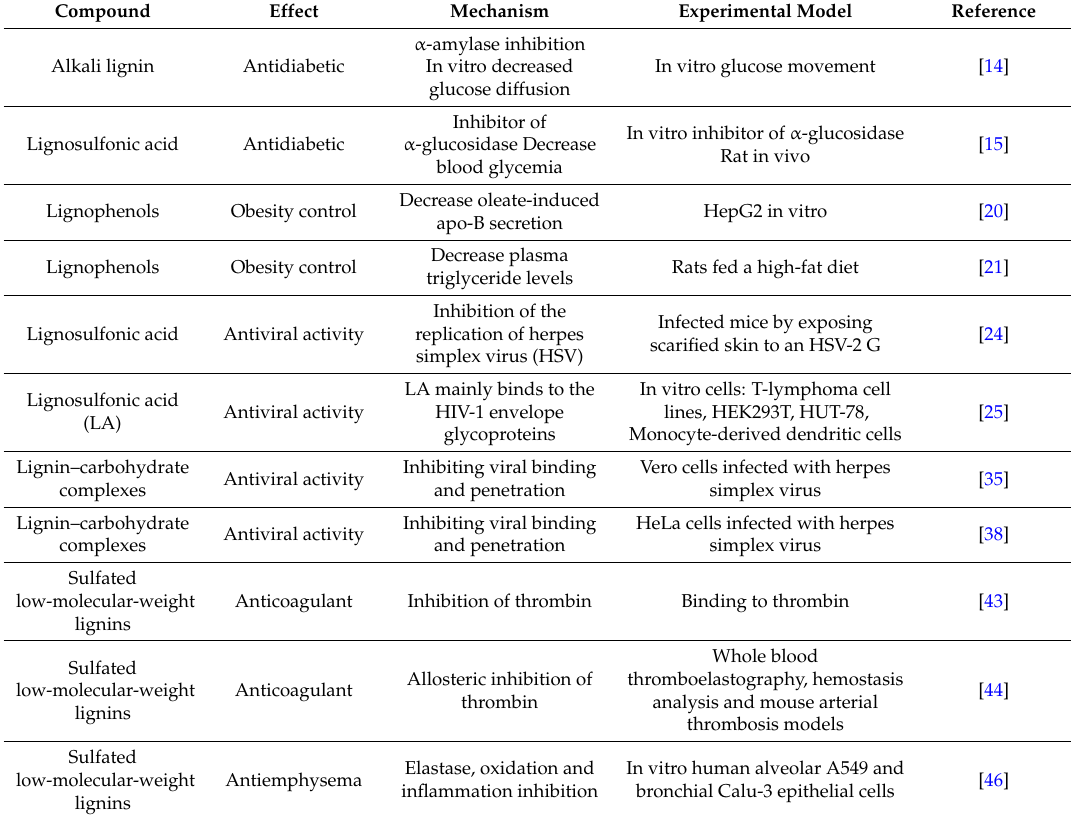
Table 1. Main pharmacological activities of lignins and their